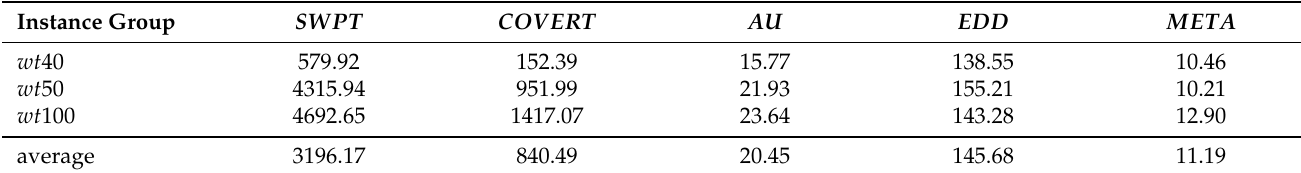
Table 1. PRD [%] to the best-known solutions for SWPT, EDD, COVERT, AU and META